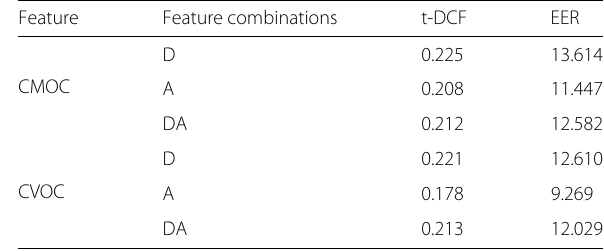
Table 11 Experimental results (t-DCF and EER(%)) on ASVspoof 2019 physical access evaluation set using dynamic features